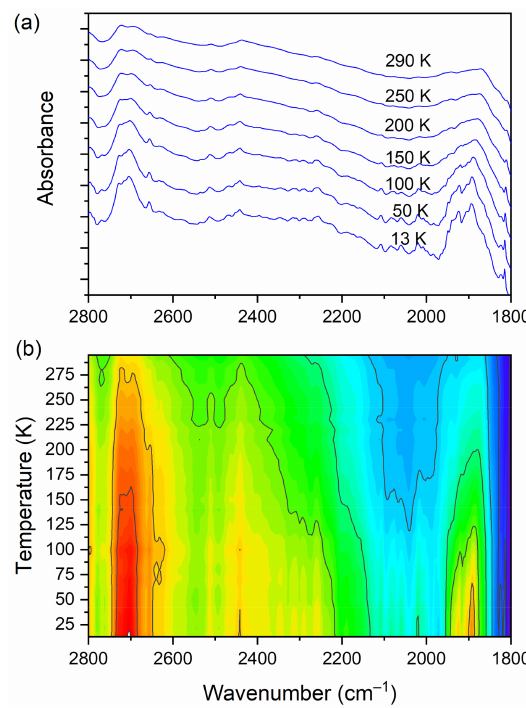
Figure 11. ( a ) IR spectra in the wavenumber range of 2800–1800 cm − 1 during cooling of the N,N- dimethylglycine–chloranilic acid co-crystal; ( b ) contour plots of IR spectra in the overtone (C–H 2 bend. ) and summation (CH bend. + CH wagg. ) regions, and O–H stretching modes (DMG + ).